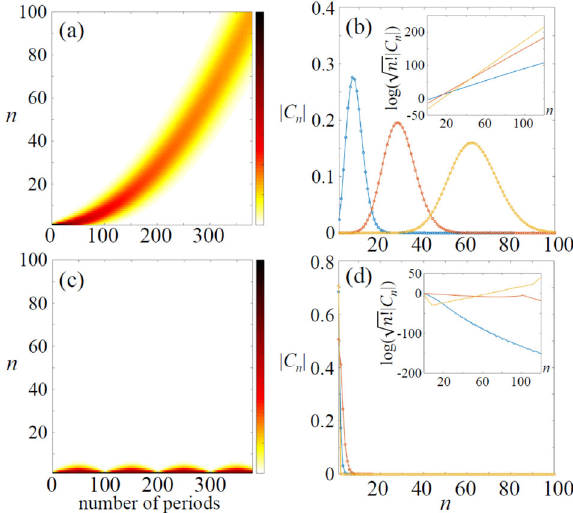
Fig. 2 Time evolution of the ground state. For ω = Ω V ( ω = 1.01 Ω V ), the time evolution is plotted in the top (bottom) panels. The intensity of ∣ C n ∣ is presented via colormap as a function of t and n in a, c. To exhibit the evolution of the coherent states, ∣ C n ∣ is displayed at speci fi c moments t = 100 T , 200 T , 300 T in ( b ) and t = 10 T , 50 T , 100 T ffiffiffiffi p n ! in ( d ). Insets show that log ð j C n jÞ is linearly increasing as a function of n in the resonant case ω = Ω V , which is equivalently ffiffiffiffi ffiffiffiffi p p n ! n ! . The slope of log ð j C n j / j α j n = j C n jÞ determines α . We use the following parameters: E J = 1, ω = 1/1.4, ϵ = 0.01, n max = 120; ℏ ≡ 1.